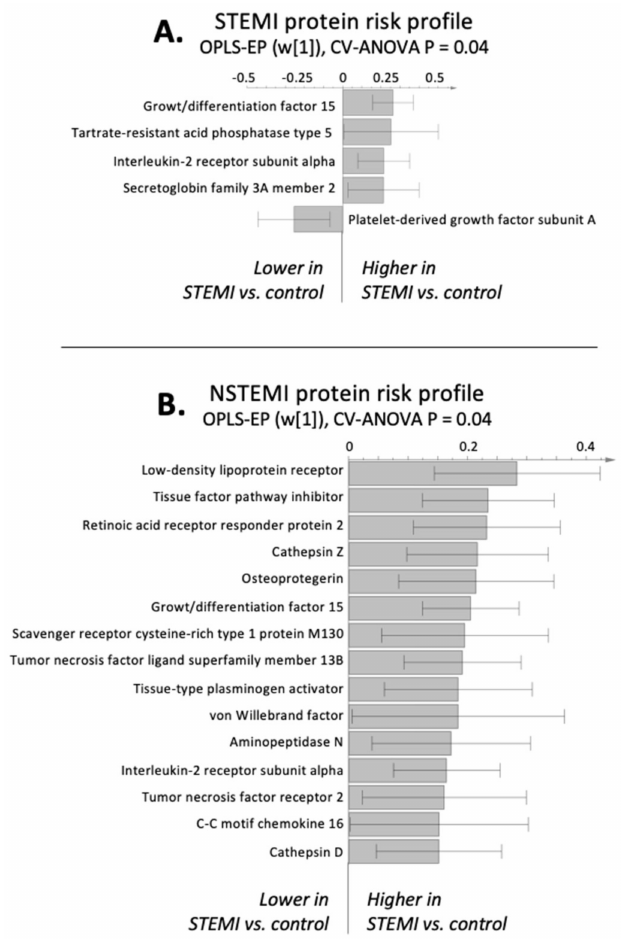
Figure 3. Infarction-specific multivariate models (OPLS-EP) calculated from the multiplex protein panel. Only proteins that are significantly ( p < 0.05) altered between cases and their matched controls are shown. ( A ) STEMI protein risk profile. ( B ) NSTEMI protein risk profile. The multivariate confidence intervals indicate significance on a 95% based on